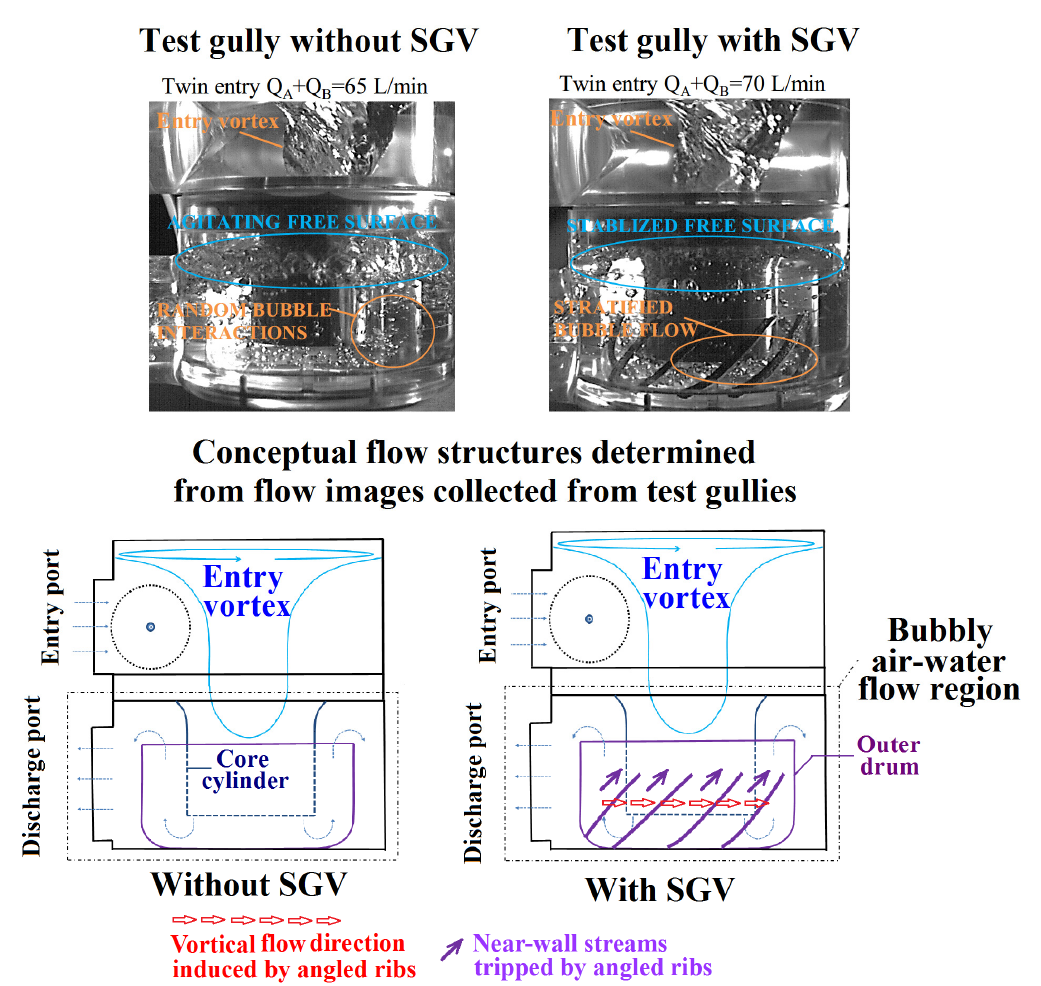
Figure 2. Air-water flow structures in test gully without SGV at Q A + Q B = 65 L/min andin test gully with SGV at Q A + Q B = 70